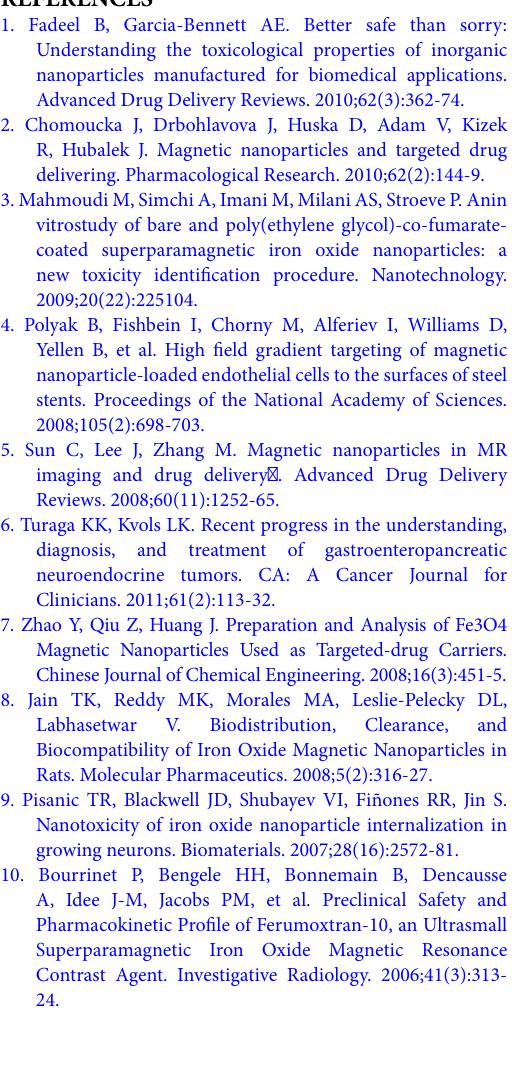
233 Nanomed Res J 4(4): 228-233, Autumn